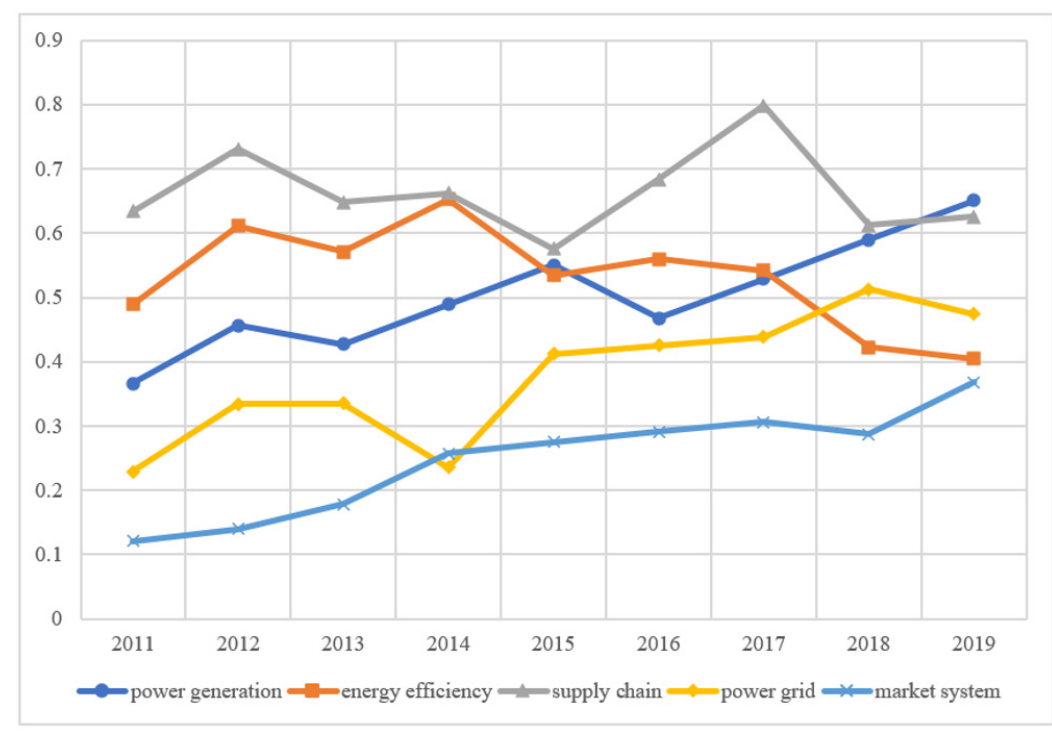
Figure 5. Evaluation score of low-carbon development in western China.